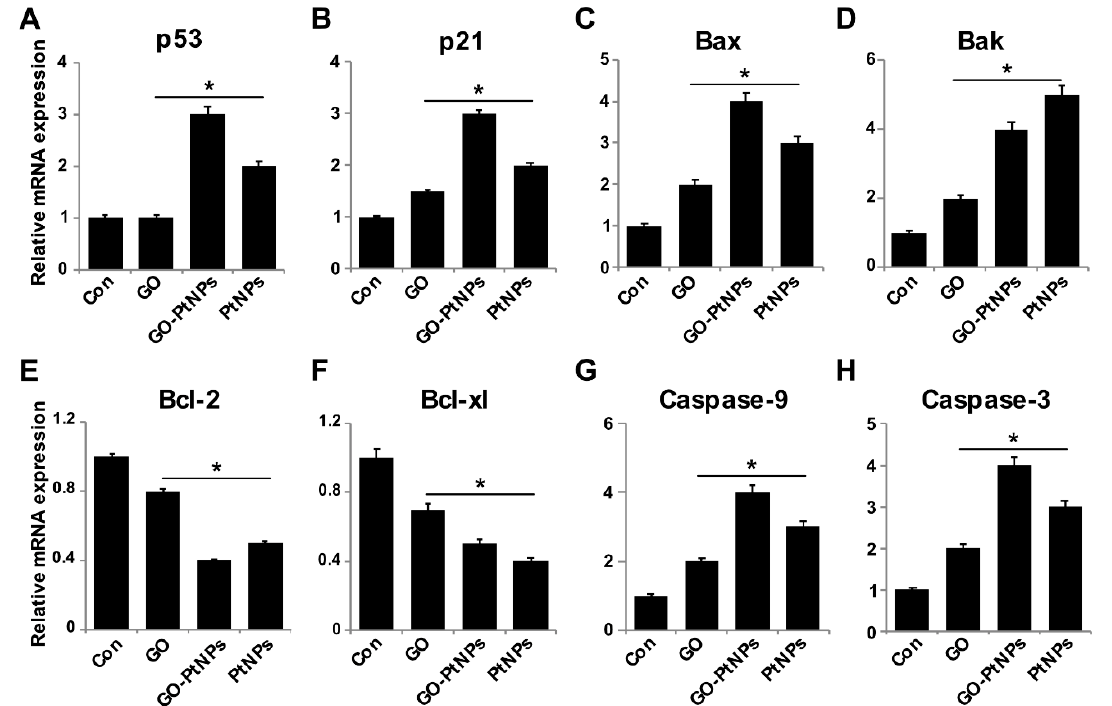
Figure 12. Effect of GO, GO-PtNPs, and PtNPs on the expression of pro- and antiapoptotic genes. LNCaP cells were treated with respective IC50 concentration of GO, GO-PtNPs, and PtNPs for 24 h. The relative messenger RNA(mRNA) expression of P53 ( A ), P21 ( B ), Bax ( C ), Bak ( D ) Bcl-2 ( E ), Bcl-xl ( F ), caspase-9 ( G ), and caspase-3 ( H ) was analyzed by quantitative reverse-transcription polymerase chain reaction in LNCaP cells treated for 24 h. After 24-h treatment, expression fold level was determined as fold changes in reference to expression values against GAPDH. Results are expressed as fold changes. There was a significant difference in treated cells compared to untreated cells with Student’s t -test (* p < 0.05).